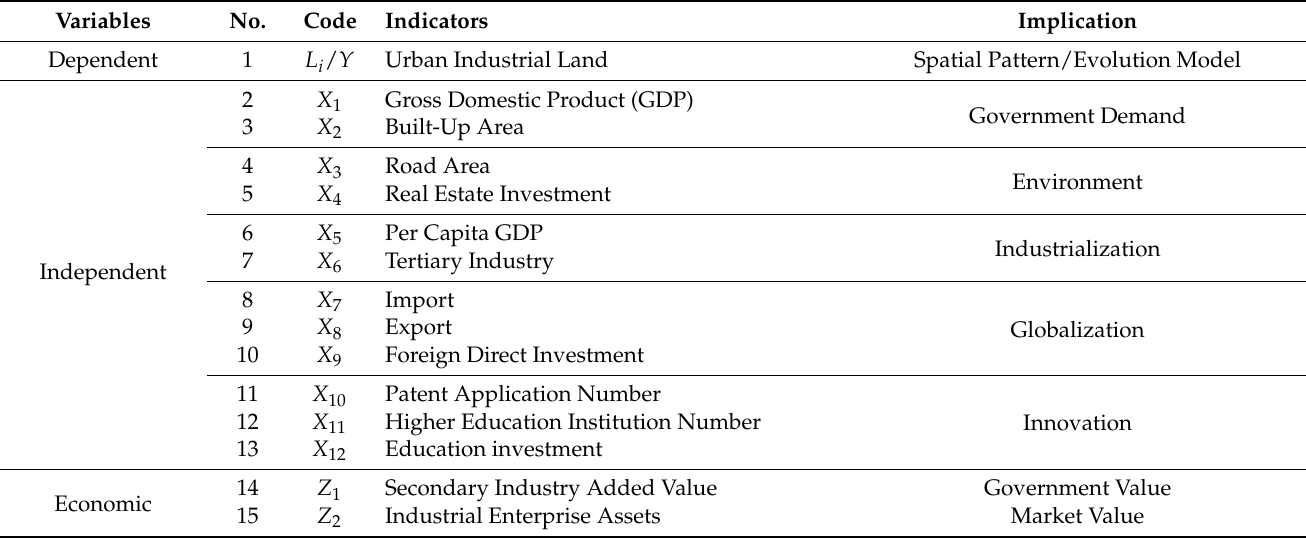
Table 1. Description and analysis of the index